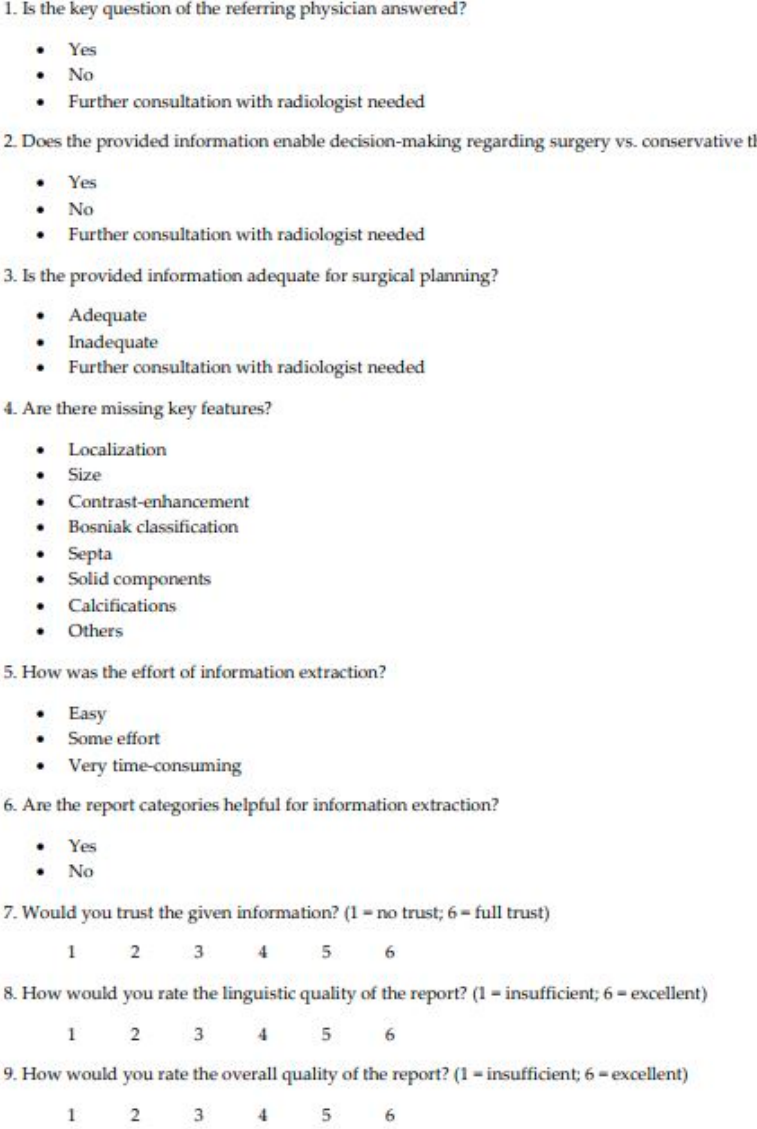
Figure 4. Questionnaire used for the evaluation of free-text reports and structured reports by the two reviewers.